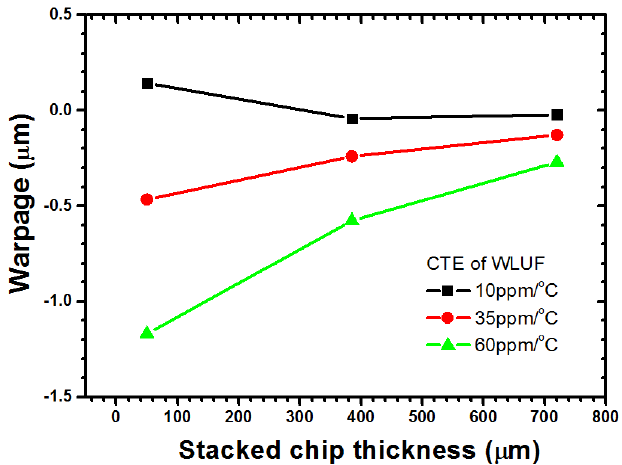
Figure 14. Interaction effect between stacked chip thickness and CTE of WLUF on packaging warpage while substrate thickness and E-value of WLUF are fixed at 50 μ m and 7 GPa, respectively.